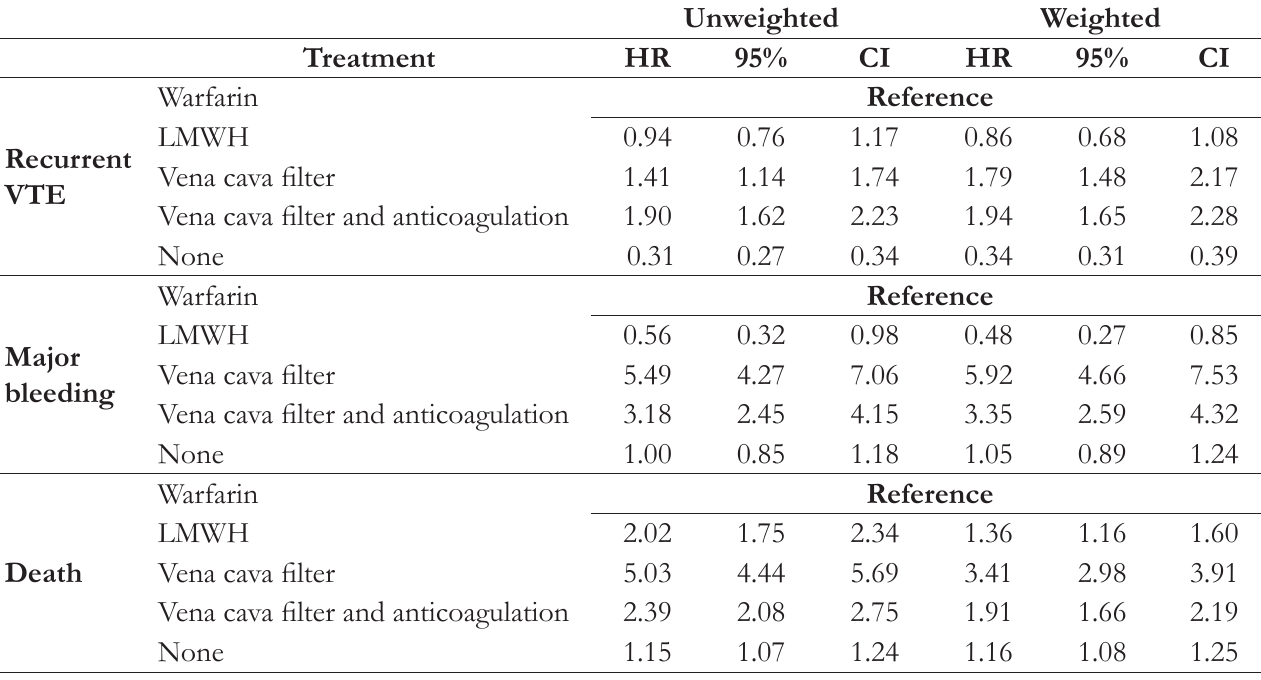
Table 2. Univariable Treatment Effect on Outcomes